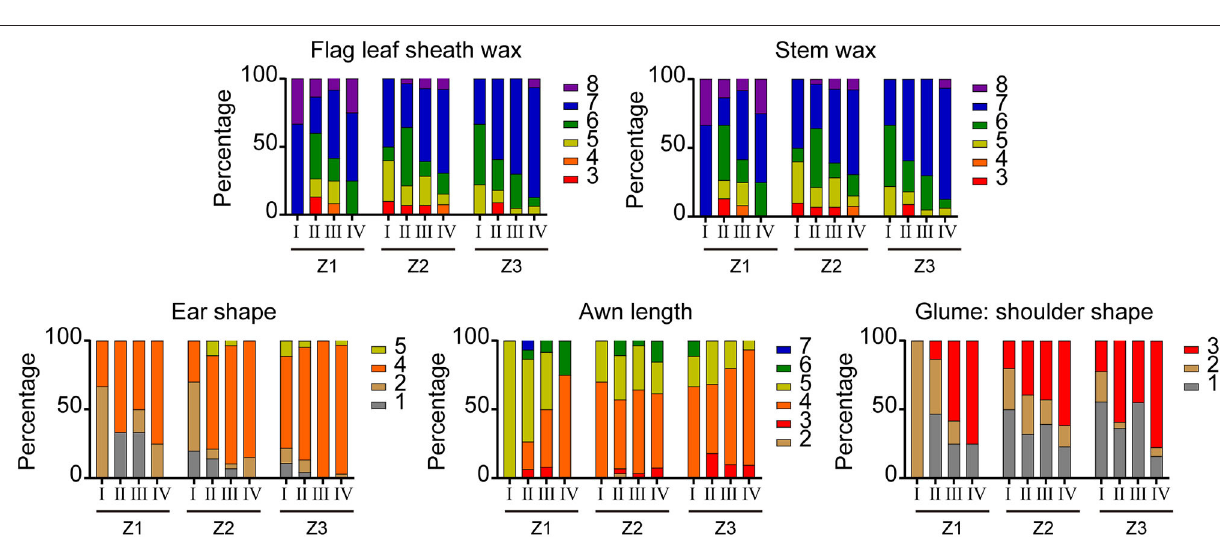
states of expression over years of type three characteristics suggested that they were not the main factors in the breeding selection